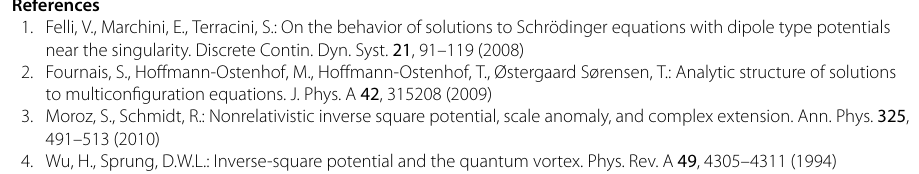
that our algorithm is very effective. We believe that this method can be extended to more complex practical